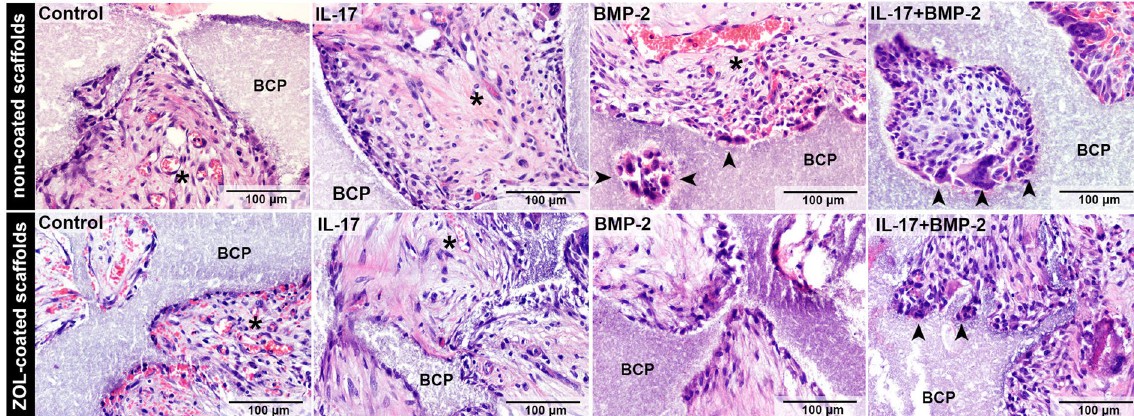
Figure 5. Day 10 H&E staining. Images are taken from the edge of the scaffold and are representative for the group. Arrowheads point to multinucleated cells indicative of osteoclasts. Asterisks indicate blood vessels. BCP, biphasic calcium phosphate.